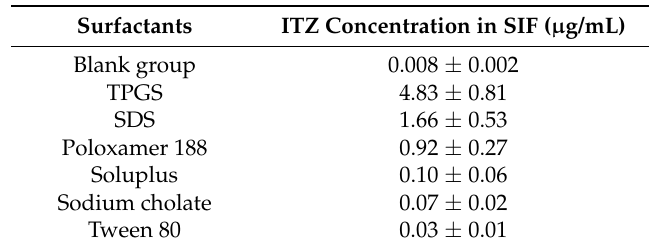
Table 2. Equilibrium solubility of ITZ in SIF containing different surfactants for 48 h (Mean ± S.D., n =